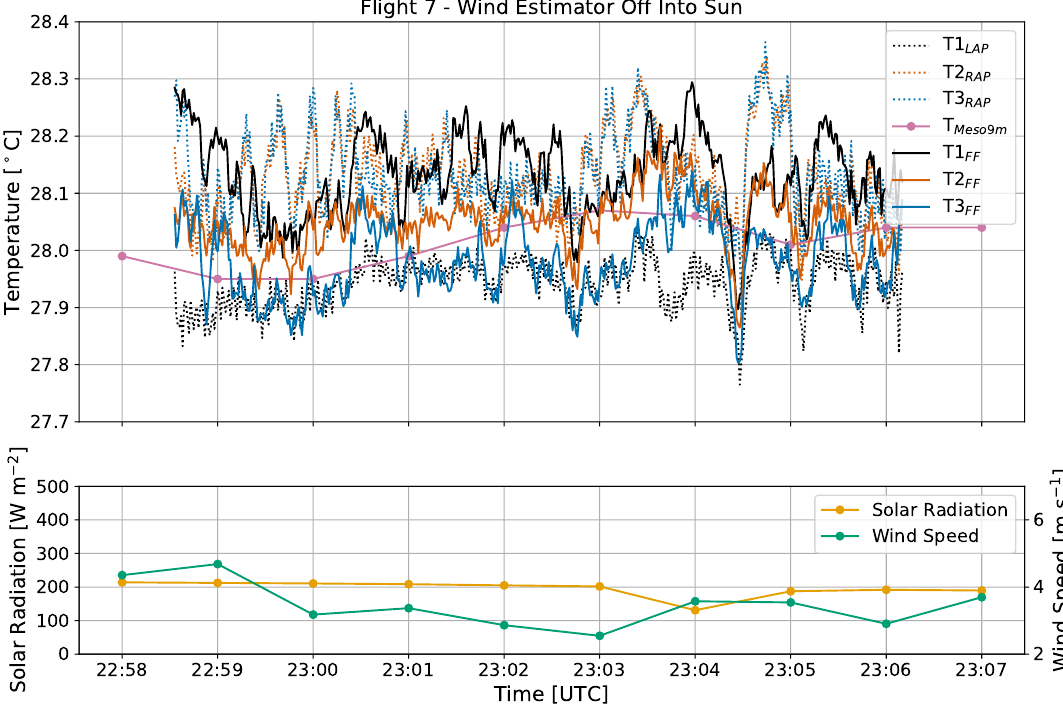
Figure 10. Time series of temperature [ ◦ C], solar radiation [W m − 2 ], and wind speed [m s − 1 ] from flight 7, with the same labeling conventions used previously. As with flight 6, the CopterSonde flew perpendicular to the wind facing the